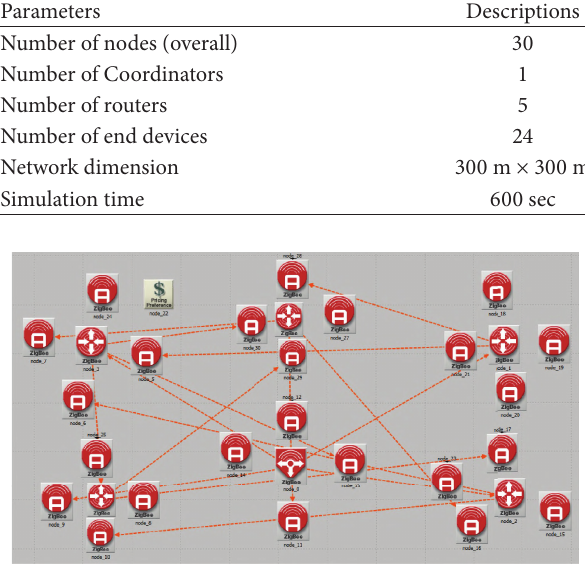
Figure 1: ZigBee network simulation scenario.